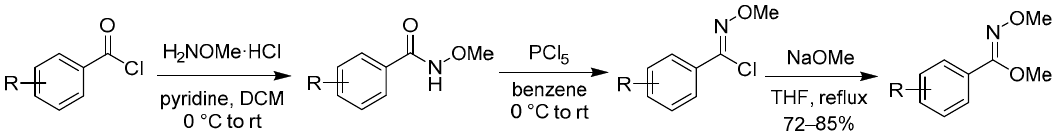
N -methoxybenzymidate and